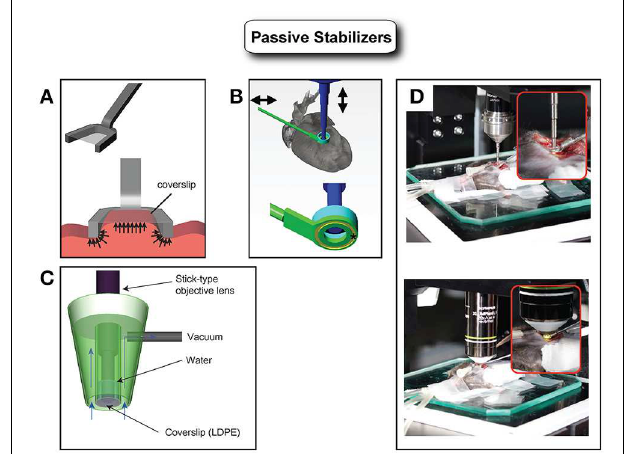
FIGURE 2 | Linear and/or nonlinear transformation models can be implemented during the post-processing phase of the acquired data. Linear models include translation, rigid (translation + rotation), similarity (translation + rotation + scale), affine and projective transformations. Nonlinear models, which consider non-linear transformations allow for more complex deformations.